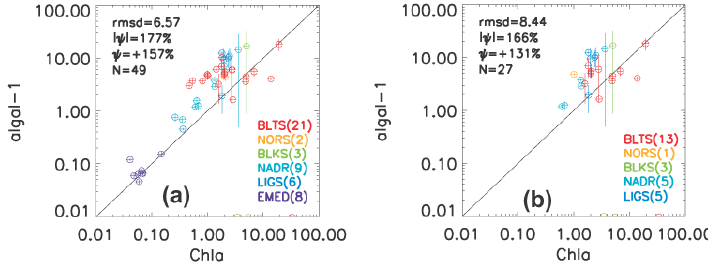
Fig. 5. Scatter plot of MERIS derived algal-1 pigment index ( algal-1 ) and in situ total chlorophyll a (Chla) in units of µgL − 1 quantified through High Performance Liquid Chromatography (HPLC) for match-ups determined with 1t =± 4h. Panels (a) and (b) display match-ups constructed neglecting and accounting for confidence flag PCD-15, respectively. Colors indicate match-ups from different seas in agreement with notations applied in Fig. 4).